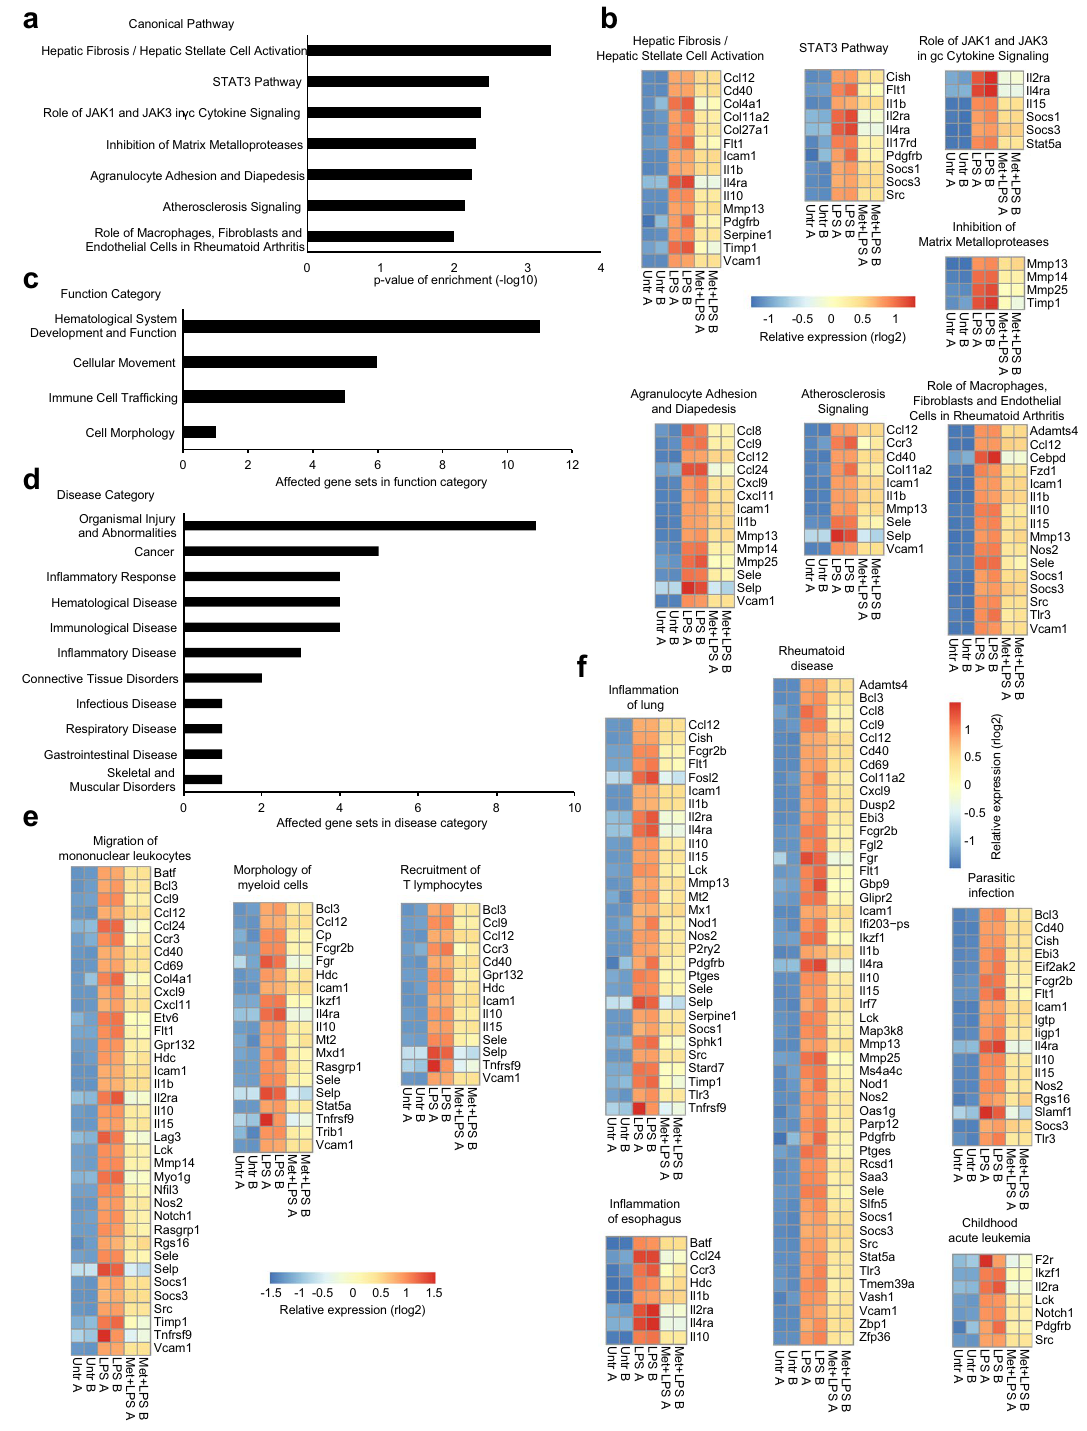
Figure 4. LPS-responsive genes downregulated by metformin are associated with a wide range of pathways, biological functions and diseases. Genes downregulated by metformin were investigated with Ingenuity Pathway Analysis. The set of 1390 LPS-responsive genes served as background against which enrichment was calculated. ( a,b ) Canonical Pathways enriched for metformin-downregulated genes. ( a ) List of affected pathways with the corresponding p-value of enrichment. ( b ) Alphabetical expression heatmaps of metformin-downregulated genes in the respective canonical pathway. Colors represent regularized, log2-transformed counts (rlog2) after normalization per row. ( c,d ) List of ( c ) function and ( d ) disease categories of gene sets enriched for metformin-downregulated genes. Shown is the number of gene sets belonging to each category (enrichment p-value < 10 –3 ). Note that several gene sets belong into more than one category. See Supplementary Table S4 for a complete list of gene sets, associated categories and enrichment p-values. ( e,f ) Alphabetical expression heatmaps of metformin-downregulated genes in the respective gene sets. Shown are examples from the ( e ) function and the ( f ) disease categories. The remaining gene sets are shown in Supplementary Fig. S3b. Colors represent rlog2 counts after normalization per